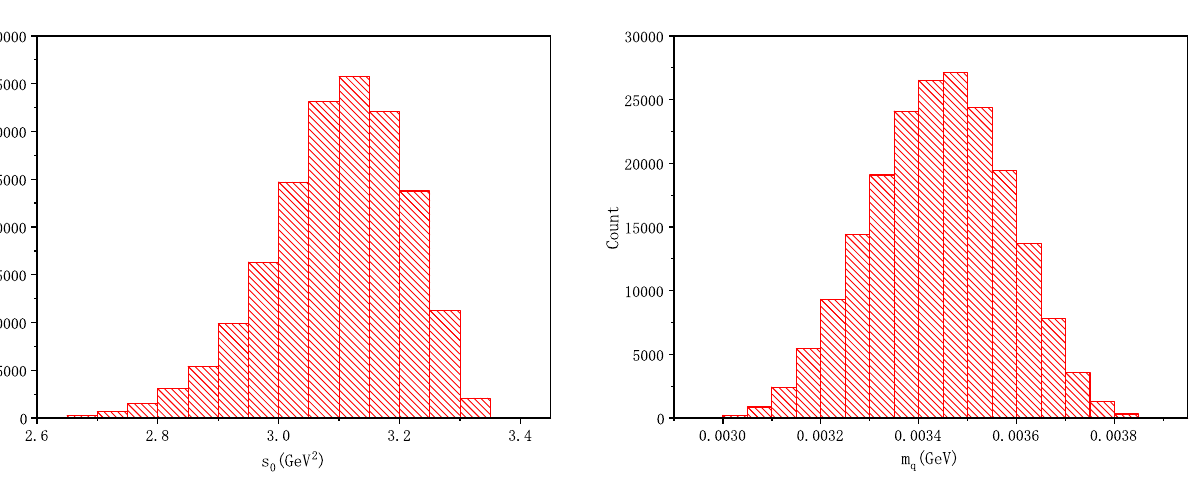
Fig. 7 The histogram distributions of the resulting parameters s 0 and m q (obtained from the RG-invariant ˆ m q ) from the repeated χ 2 mini- mization procedures by taking the large amount of random samples